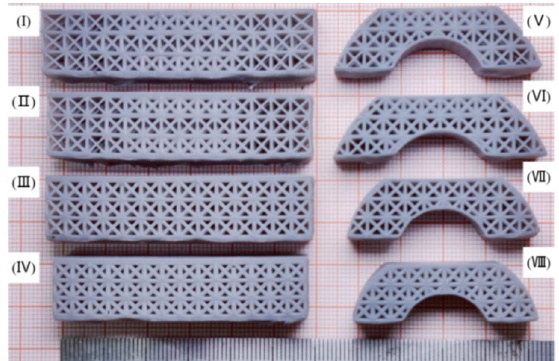
Figure 7. Eight types of lattice samples via SLA for three-point bending: ( I ) Heterogeneous lattice